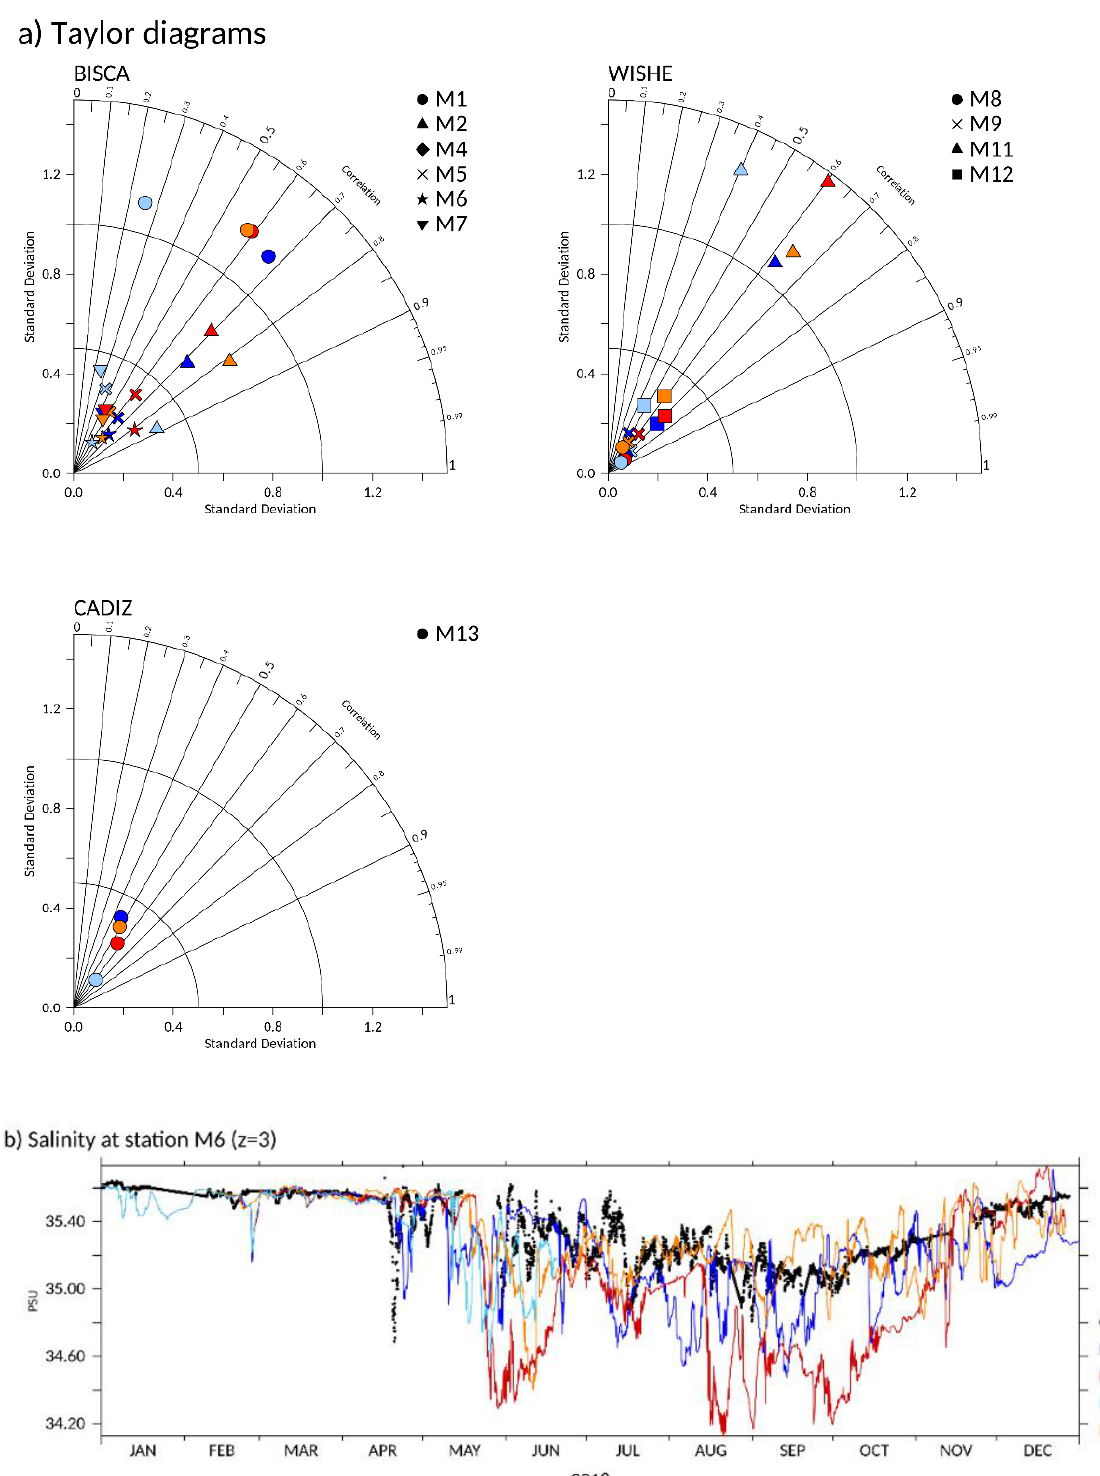
Figure 7. ( a ) Taylor diagrams showing observed-modelled salinity comparisons at moorings in the BISCA, WISHE and CADIZ areas. Each location is represented by a different symbol, whereas colors represent the model scenario simulation (IBI_REF in blue, IBI_CLM in light blue, IBI_LAM in red and IBI_NOR in orange). M3, M4 and M10, because of the important bias between observations and simulations, are not represented here. ( b ) Timeseries of salinity at station M6, at the shelf-break of Santander, Northern Spain, in BISCA. The color code is the same as in panel (a). As each subregion features its proper dynamics and local processes, the assessment of the salinity variability and fronts location, and the assessment of the impact of the river discharge forcing on the IBI configuration, have been conducted separately in BISCA, WISHE and CADIZ areas. 3.2.1. BISCA Region